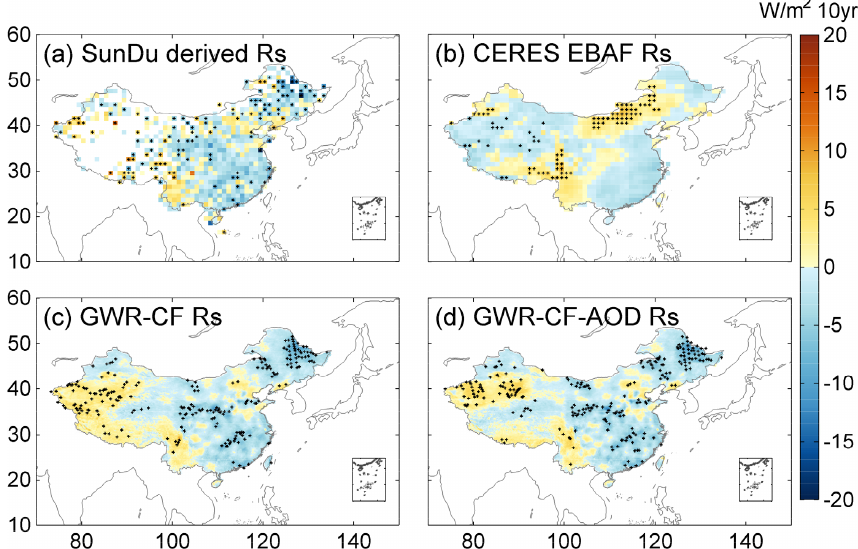
Figure 8. Spatial distributions of monthly anomaly trends of surface solar radiation ( R s ) from 2000 to 2017. The first line (a, b) shows the SunDu-derived R s and CERES EBAF R s ; the R s -derived GWR fusion methods are shown in the second line (c, d) . Panel (c) incorporates only CF, and panel (d) incorporates CF and AOD. The black dots on the maps represent significant trends ( P < 0 .